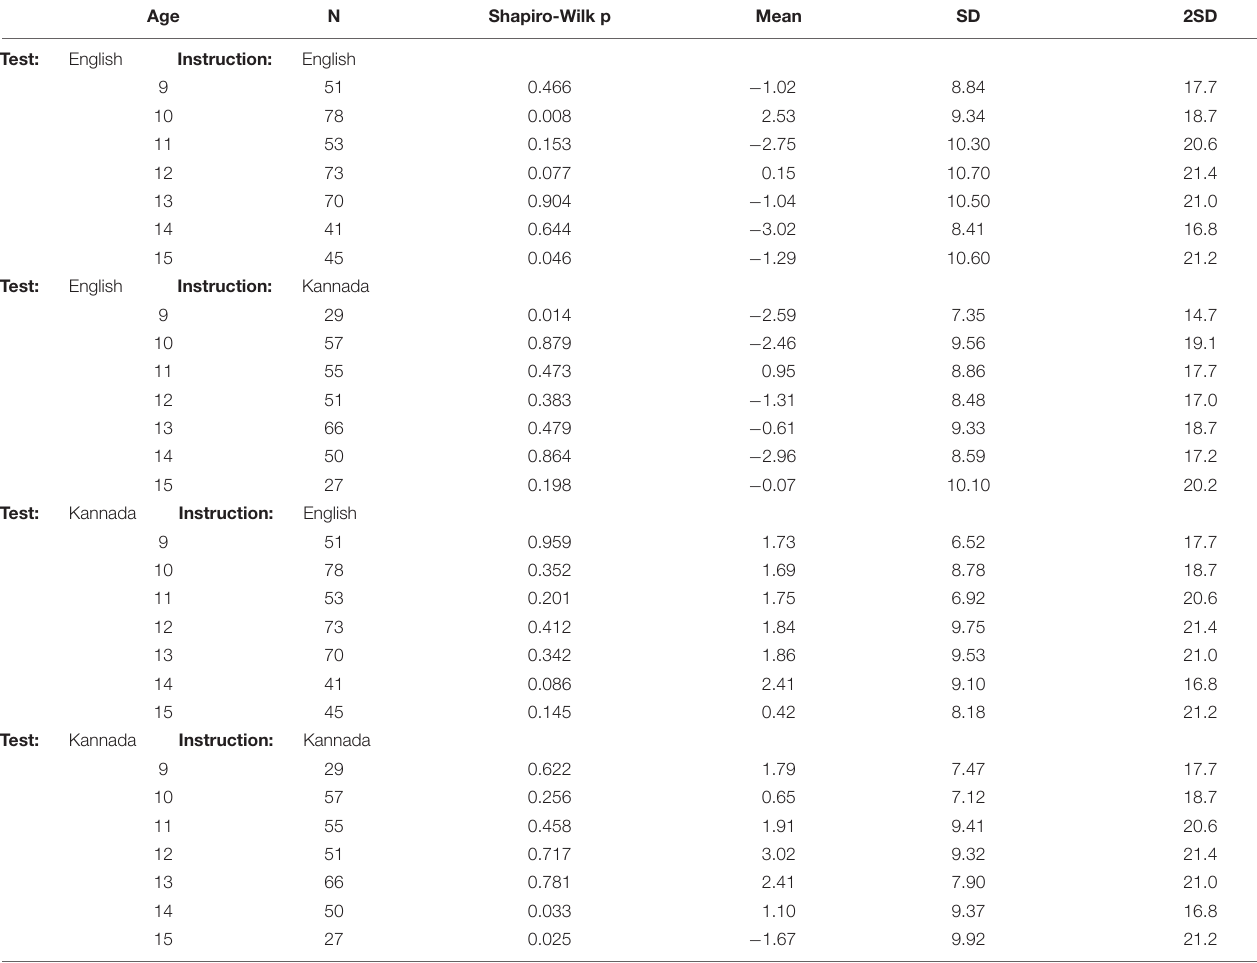
TABLE 5 | Reading rate differences: Summary statistics, by test, medium of instruction, and age. Age